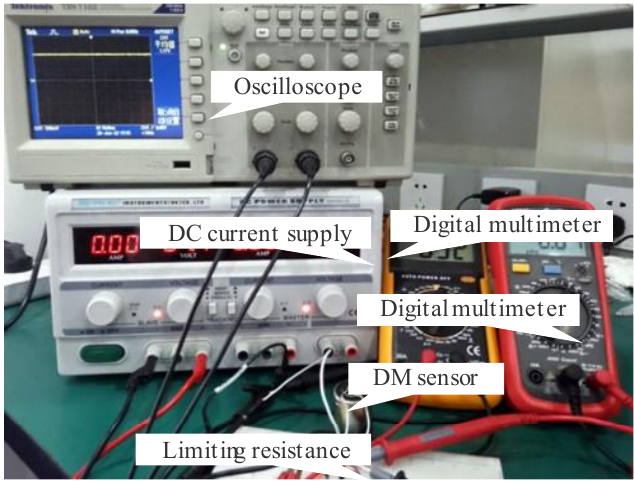
Figure 19. The instrument used for the DC excitation method.